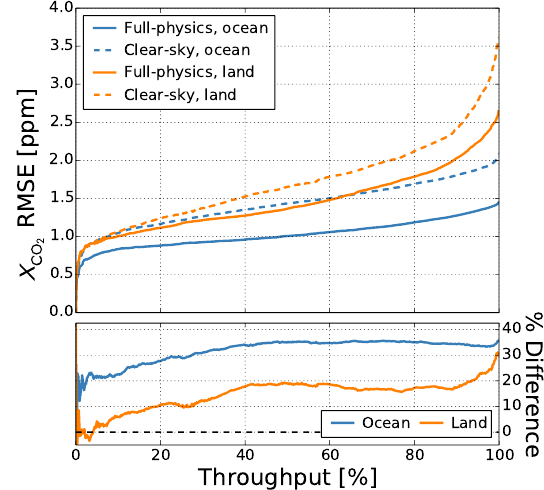
Figure 8. DOGO filters applied to full-physics (solid) and clear- sky (dashed) retrievals performed on GOSAT measurements for ocean (blue) and land (orange) surfaces. Four variables were cho- sen and optimized by the DOGO system. The x axis is through- put, which represents the percentage of data that remains after ap- plying the DOGO filters. The y axis in the top panel is the X CO 2 RMSE. The y axis in the bottom panel is the percent difference be- tween the clear-sky X CO RMSE ( E 1 ) and the full-physics X CO 2 2 RMSE ( E 2 ): (E 1 − E 2 )/( 0 . 5 · (E 1 + E 2 )) · 100. Positive values in- dicate smaller full-physics X CO RMSEs, while negative values in- 2 dicate smaller clear-sky X CO 2